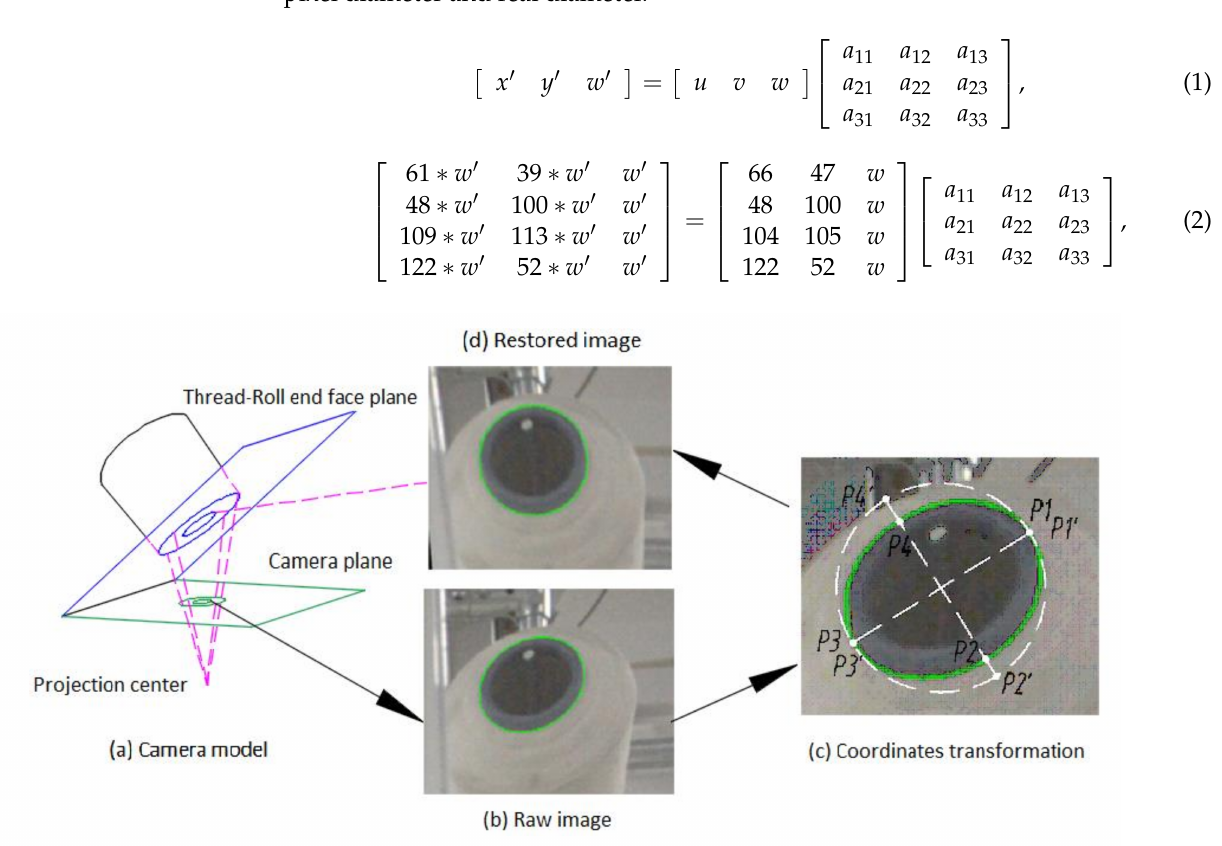
Figure 4. Shows the progress of perspective transformation. ( a ) The camera plane is not parallel to the bobbin’s end face plane, so it lead to the bobbin’s end face being ellipse in the raw image. ( b ) Bobbin’s end face is ellipse in raw image. ( c ) Calculating the vertex coordinates. ( d ) The transformed image, converting the ellipse into a